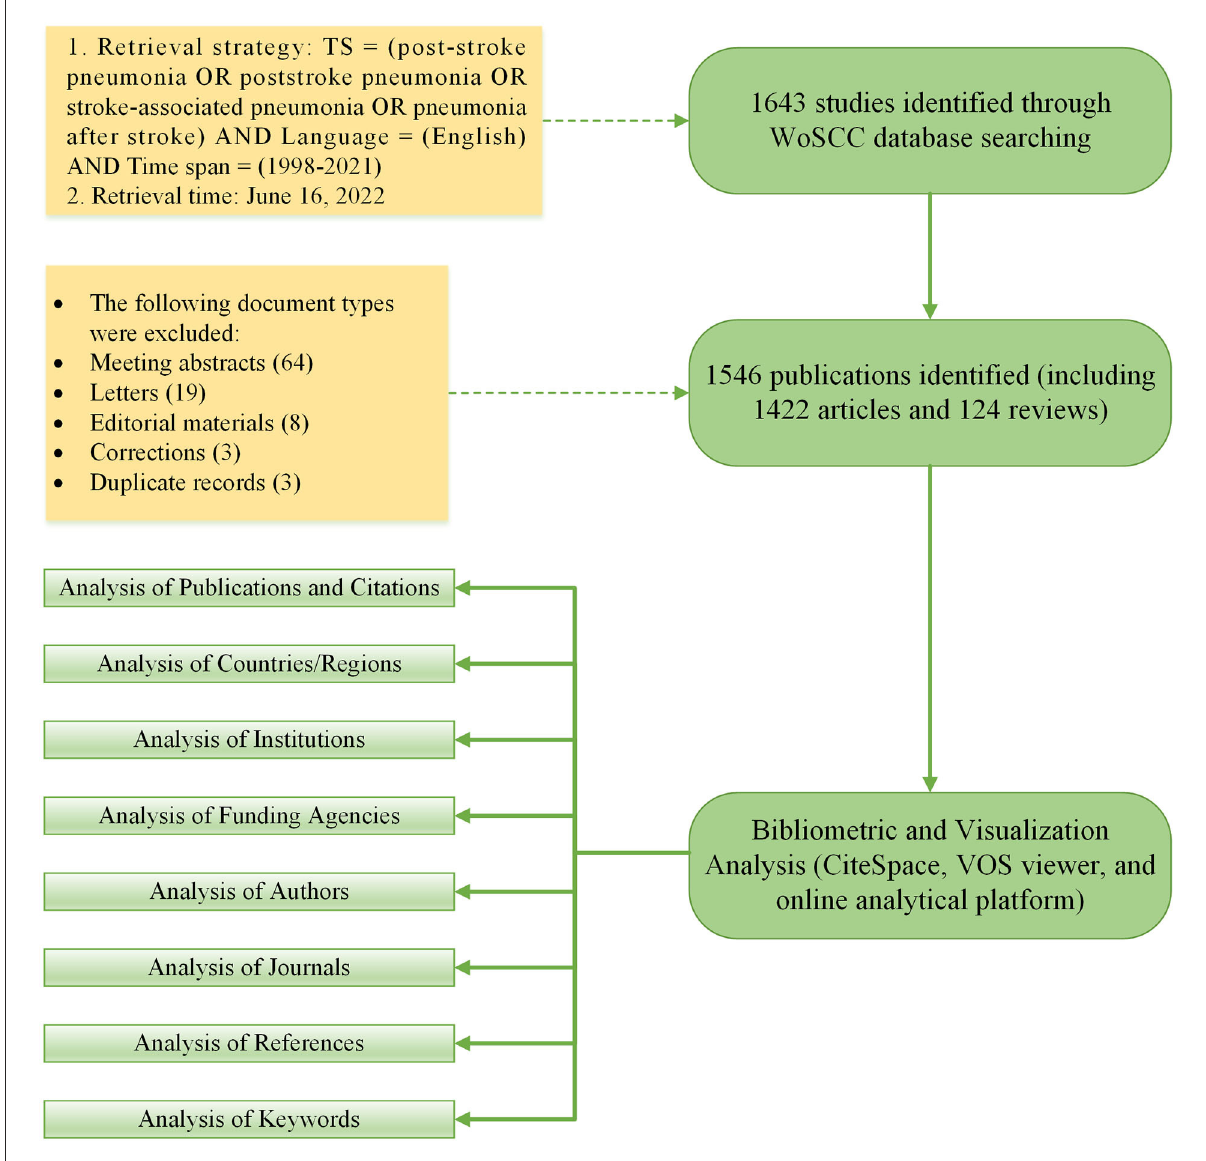
FIGURE1 Flowchart for the identification and selection of